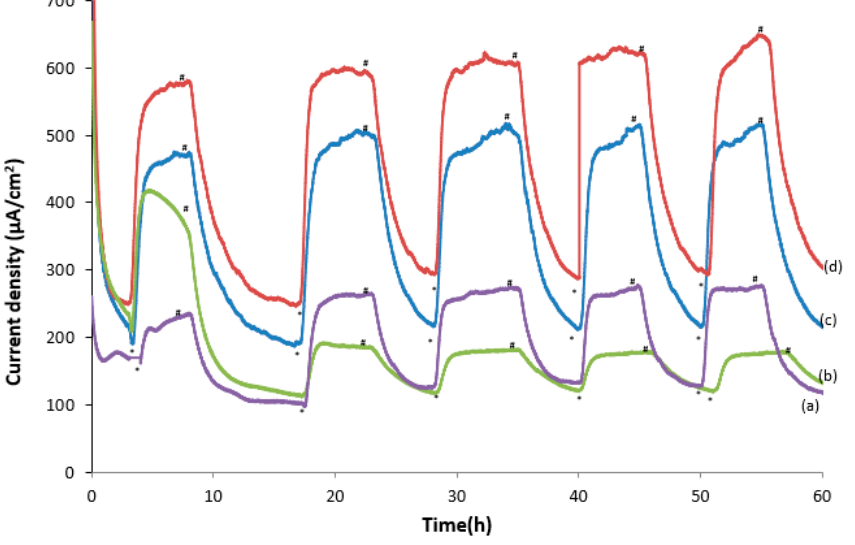
Figure 1. Electro-catalytic performance in oxygen generation from water of PEDOT/nano Co 3 O 4/ rGO nanocomposites coated on FTO glass electrodes, with and without light illumination, where the polymerization mixtures used to fabricate the nanocomposites contained 110 mg of nano Co 3 O 4 and rGO in the following quantities: ( a ) 4.0 mg, ( b ) 3.0 mg, ( c ) 1.0 mg, and ( d ) 2.0 mg. Conditions: applied bias on the nanocomposite electrodes of 0.80 V (vs Ag/AgCl) in 0.2 M Na 2 SO 4 (pH 12) (* = ’light on’, # = ’light off’).